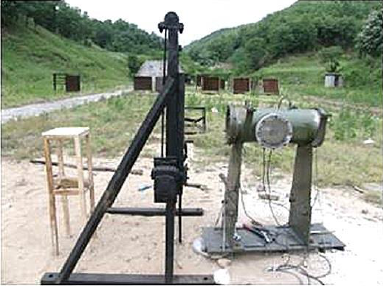
Figure 8. Field experimental device.